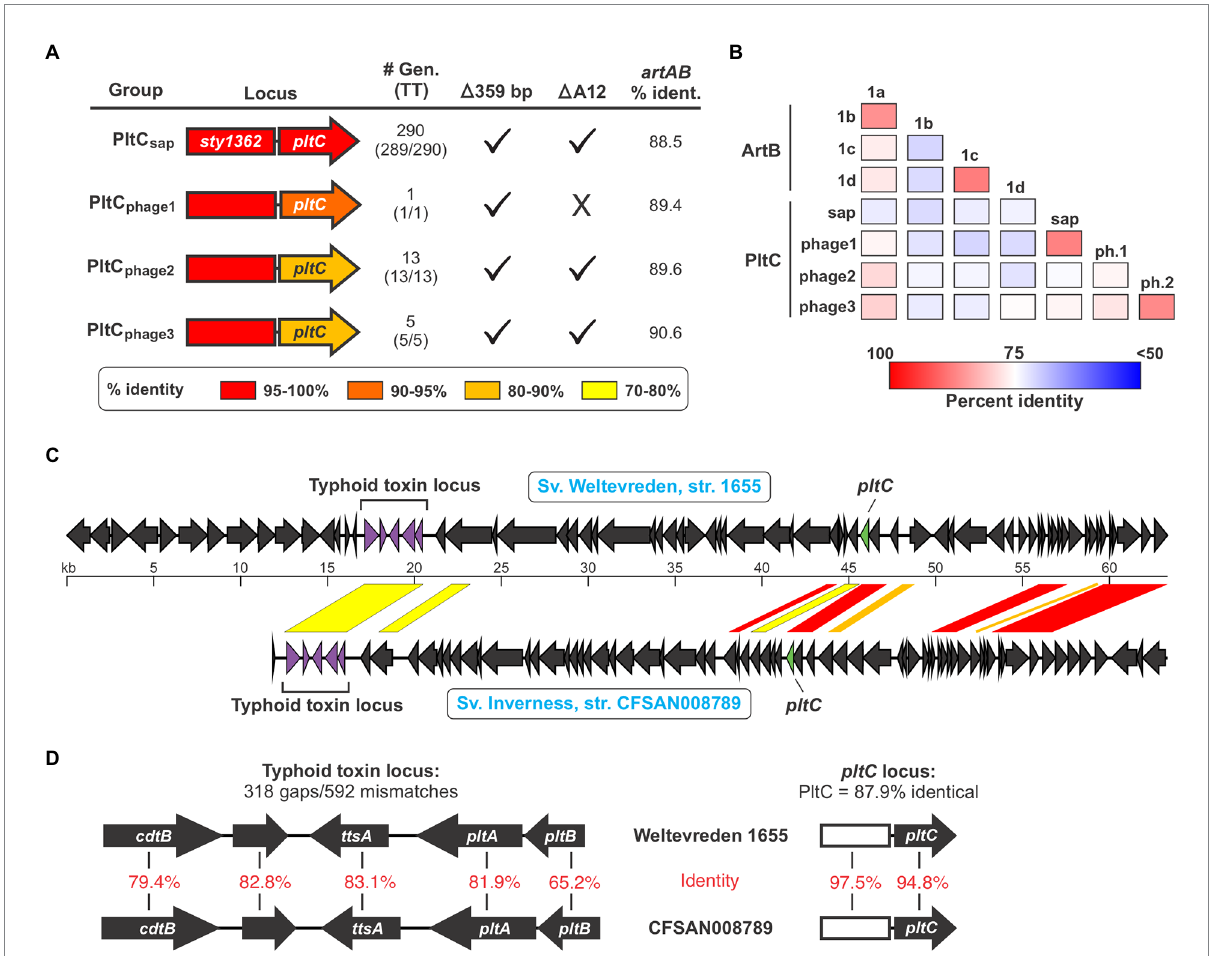
FIGURE 3 The pltC genetic element has been subject to significant diversification and horizontal transfer within the Salmonella lineage. (A) Summary of key features and data for the different groups of pltC genetic elements identified in this study including: a gene diagram that uses a colour scale to show the percent sequence identities of the artA pseudogenes and pltC genes compared to the S . Typhi locus (the representative member of the PltC sap group), the number of genomes in the NCBI nr DNA sequence database that encode that subtype and how many of those genomes also encode a typhoid toxin islet [#Gen (TT)], whether or not these subtypes have the salient pltC -specific features highlighted in Figure 2A including the 359 bp deletion and the deletion of the 12th base pair of the artA coding sequence, and the percent DNA sequence identity of these genetic elements compared to S . Typhimurium DT104 artAB (disregarding the 359 bp deletion). For sequence comparisons, the representative member of each pltC group was used (see Supplementary Dataset S3). (B) Percent protein sequence identity matrices comparing the different ArtB subtypes and PltC groups. Values generated using multiple sequence alignments of the representative member of each subtype/group. (C) Gene diagrams comparing divergent prophages that encode both a pltC locus and a typhoid toxin locus. Regions of significant sequence similarity between these prophages are shown using a color scale to indicate the percent sequence identity. (D) Gene diagrams and DNA sequence comparisons of the typhoid toxin and pltC loci of the prophages shown in (C)